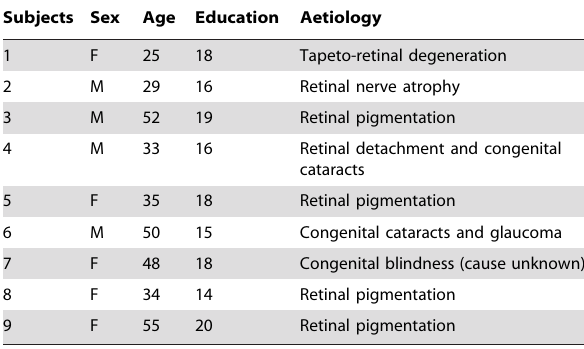
Table 3. Description of CBS (Experiment